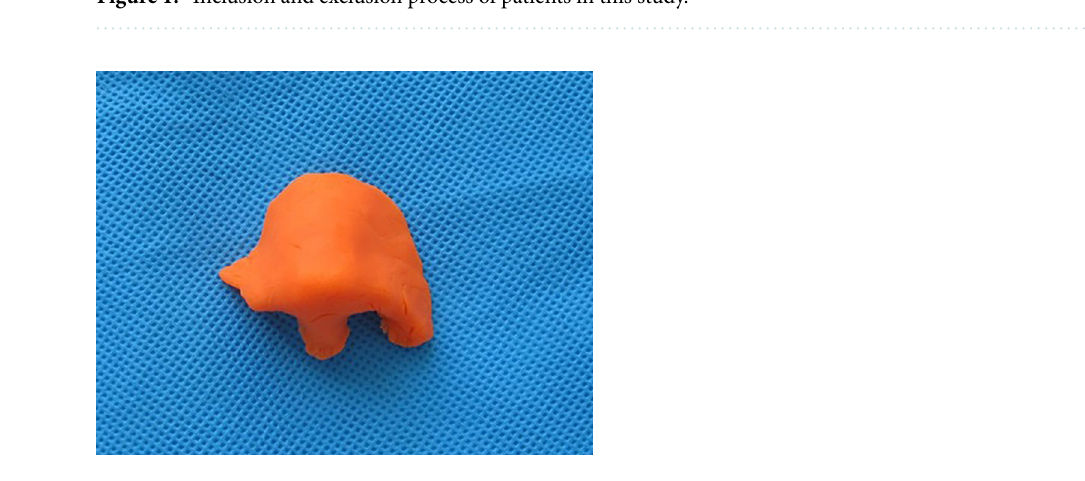
Figure 2. A clay model of the preoperatively designed